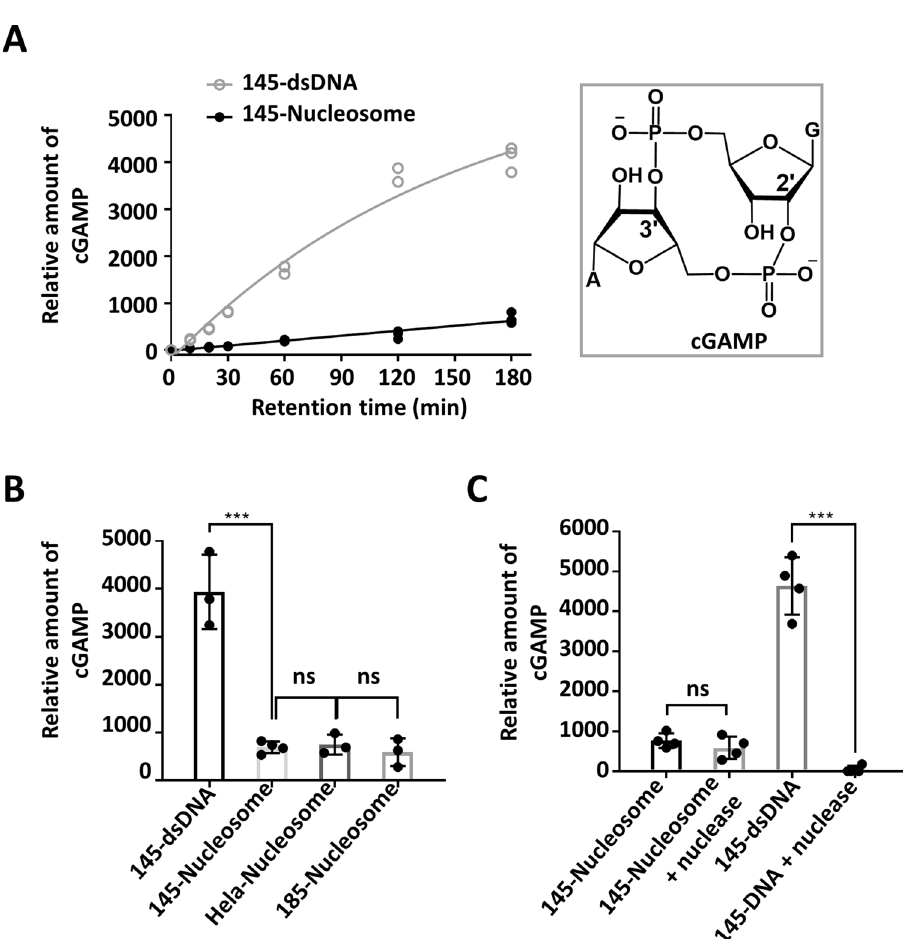
Figure 3. In vitro analyses of cGAMP generation upon incubation of cGAS with dsDNA or nucleosomes. ( A ) Kinetics of cGAMP production induced by 145-nucleosomes and 145-dsDNA. ( B , C ) Comparison of cGAMP production after incubation of cGAS with different dsDNA and nucleosomes for 3 h. Reaction conditions: dsDNA or nucleosomes (80 ng DNA/μl) were mixed with human cGAS (2 μM) in a Tris–HCl buffer (20 mM, pH 7.6, 60 mM NaCl, 2.5 mM ATP, 2.5 mM GTP, 5 mM MgCl 2 ). After incubation at 37 °C, aliquots were taken and analysed by UPLC-MS. For all graphs, error bars indicate the mean ± standard deviation of three independent experiments. Statistical significance was determined based on Student’s t -test (ns, p > 0.05; *0.05 > p > 0.01; **0.01 > p > 0.001; ***0.001 >